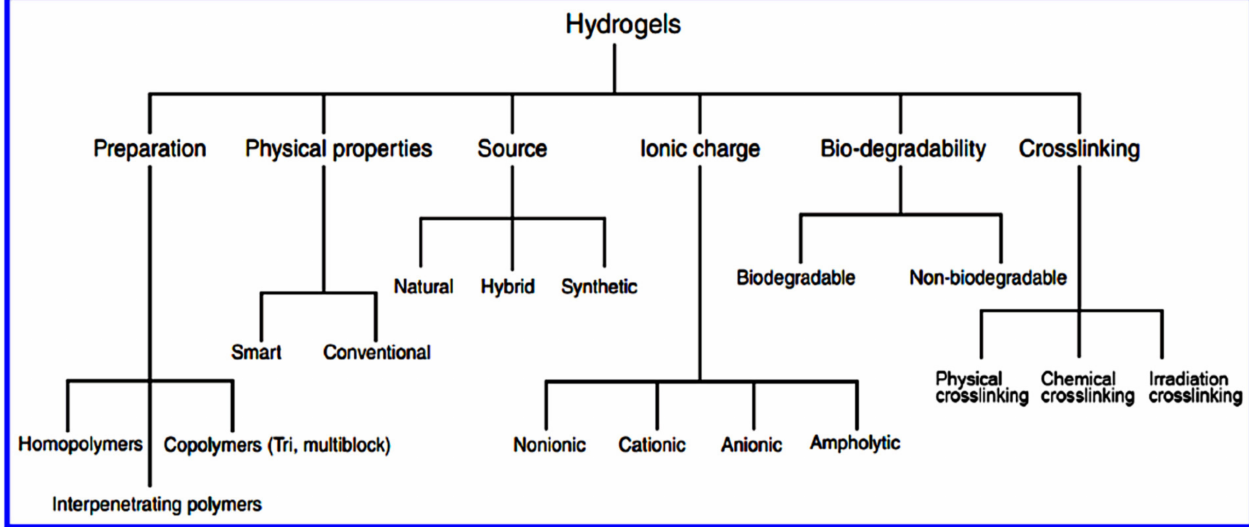
Figure 1. Classification of polymer hydrogels [220]. The important parameters, which should be considered based on the problem-solving plan. Copyright 2016 John Wiley@Sons. Reprinted with permission from ref.